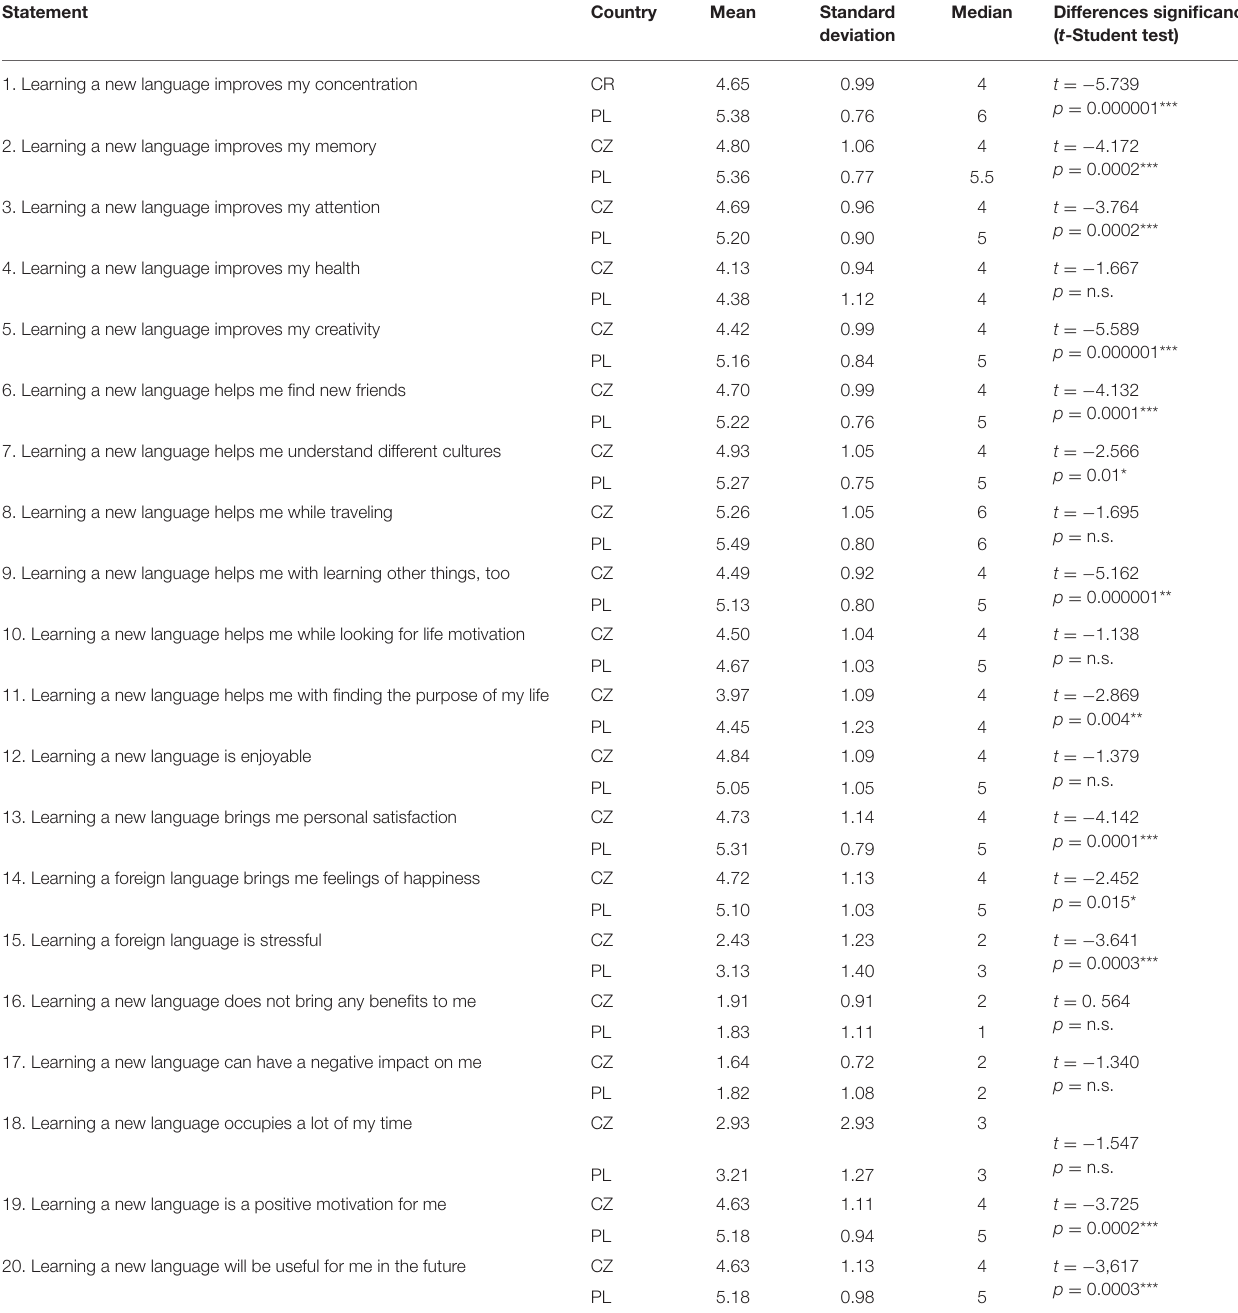
TABLE 2 | The basic statistics for the Czech and Polish groups and differences in perceived outcomes. Statement Country Mean Standard